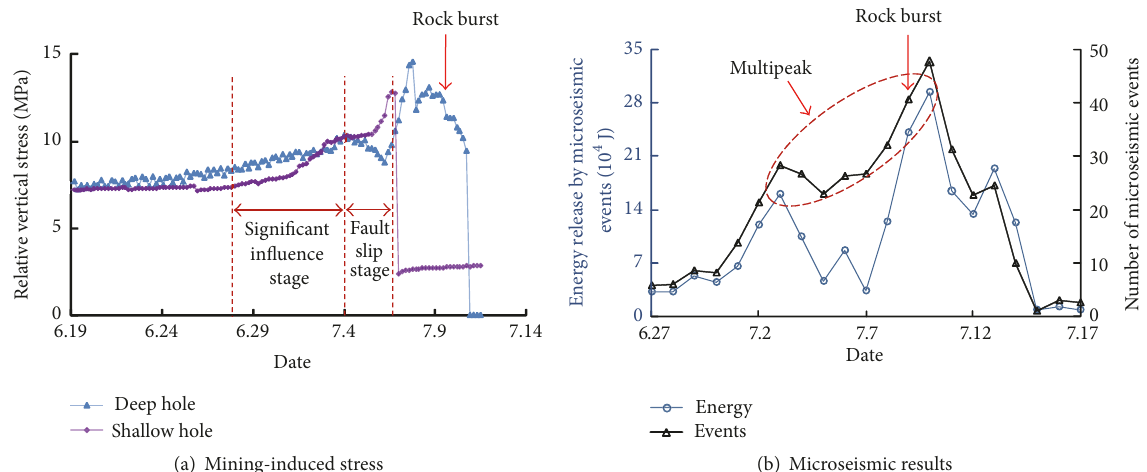
Figure 7: Monitoring results of fault-slip rock burst.